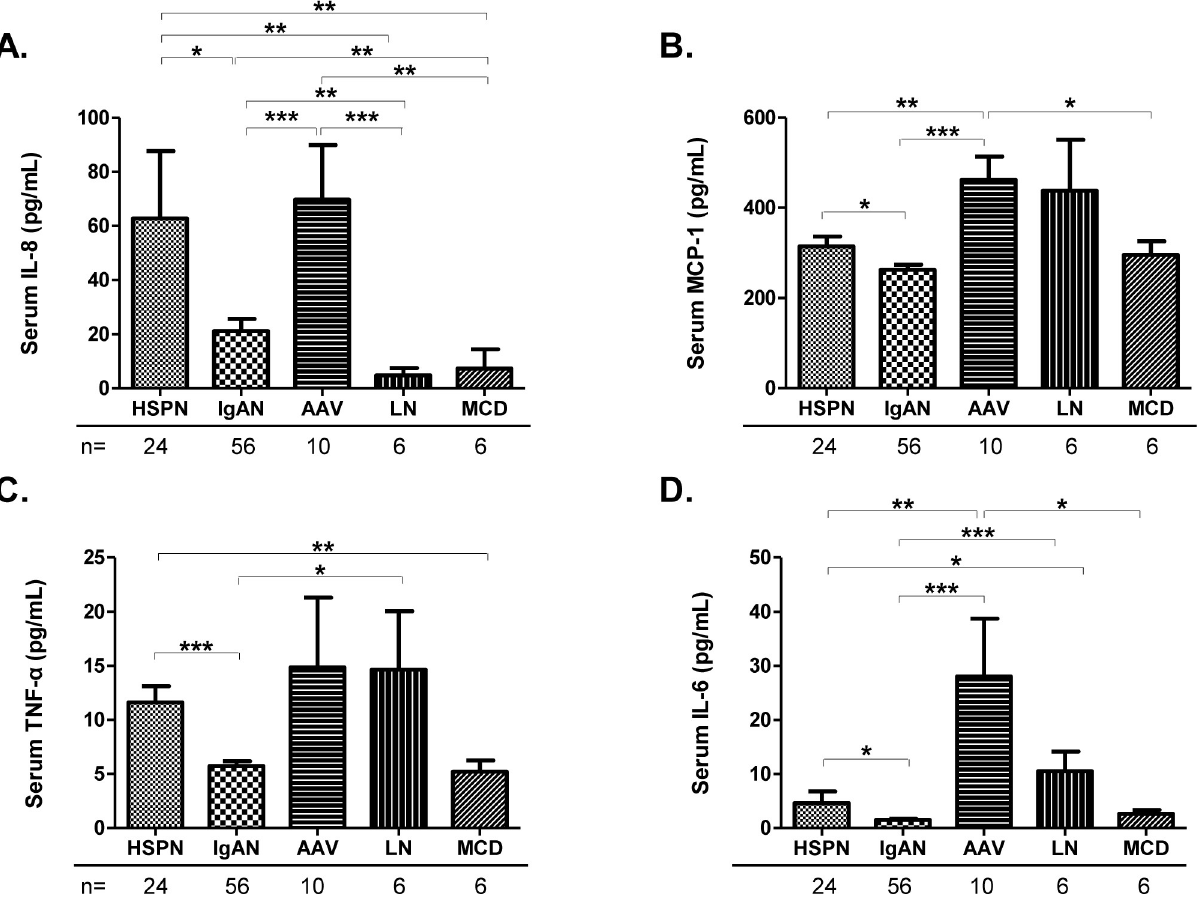
Fig 2. Serum inflammatory cytokines levels determined by ELISA between patients with HSPN or IgAN. Levels for serum IL-8 ( A ), MCP-1 ( B ), TNF- α ( C ), and IL-6 ( D ) among patients with HSPN, IgAN, AAV, LN, or MCD. Values are presented as means ± SEM. Data were statistically analyzed using Kruskal-Wallis tests and Mann-Whitney U tests. � P < 0.05, �� P < 0.01, and ��� P < 0.001.